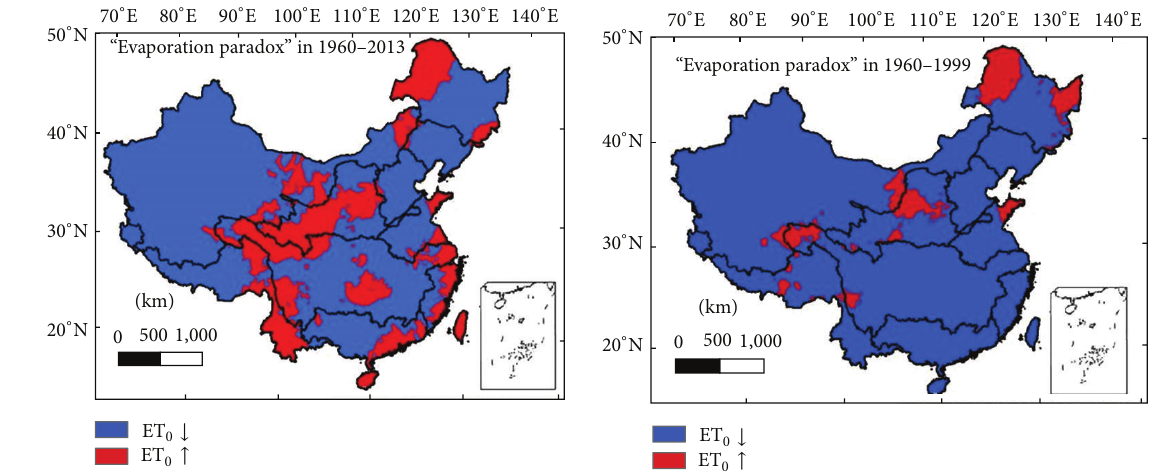
Figure 4: Distribution of evaporation paradox in different